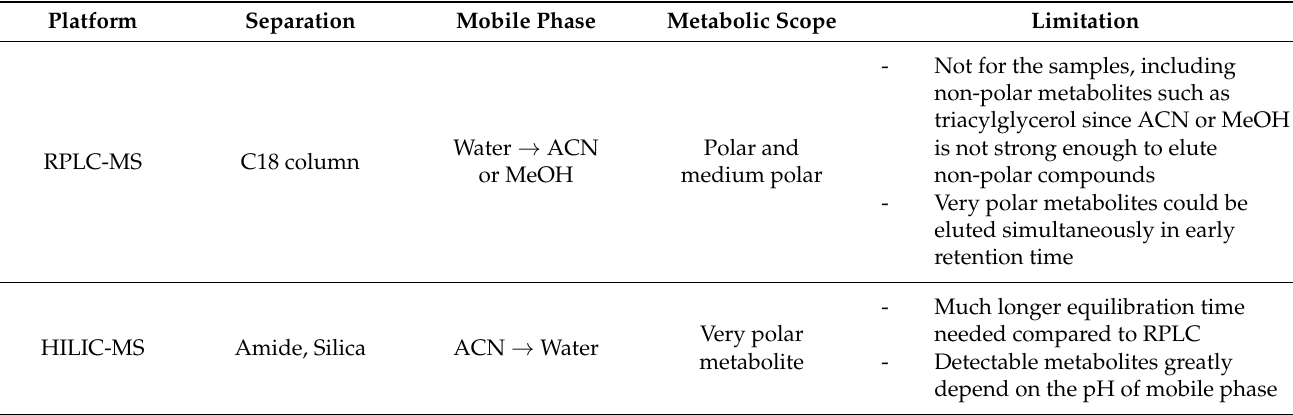
Table 2. Instrument for MS-based metabolomics